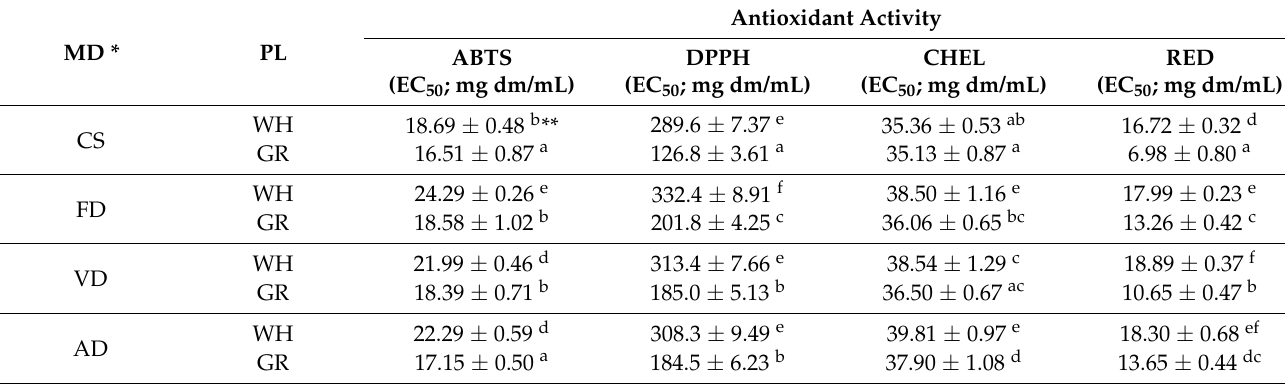
Table 9. Antioxidant activity of dried white and green shaft of leek.